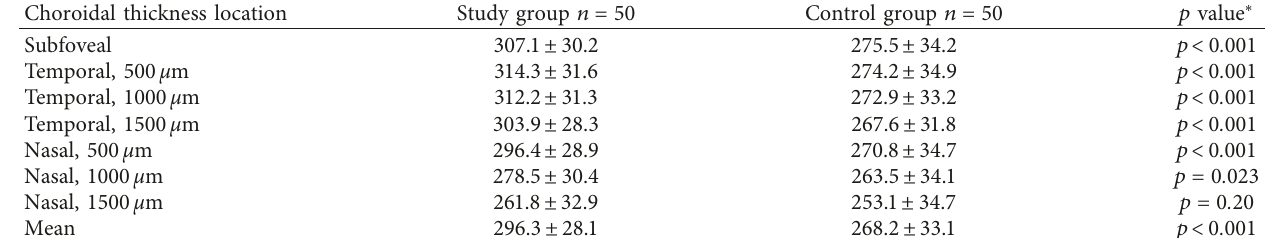
Table 3: Choroidal thickness differences between the groups.